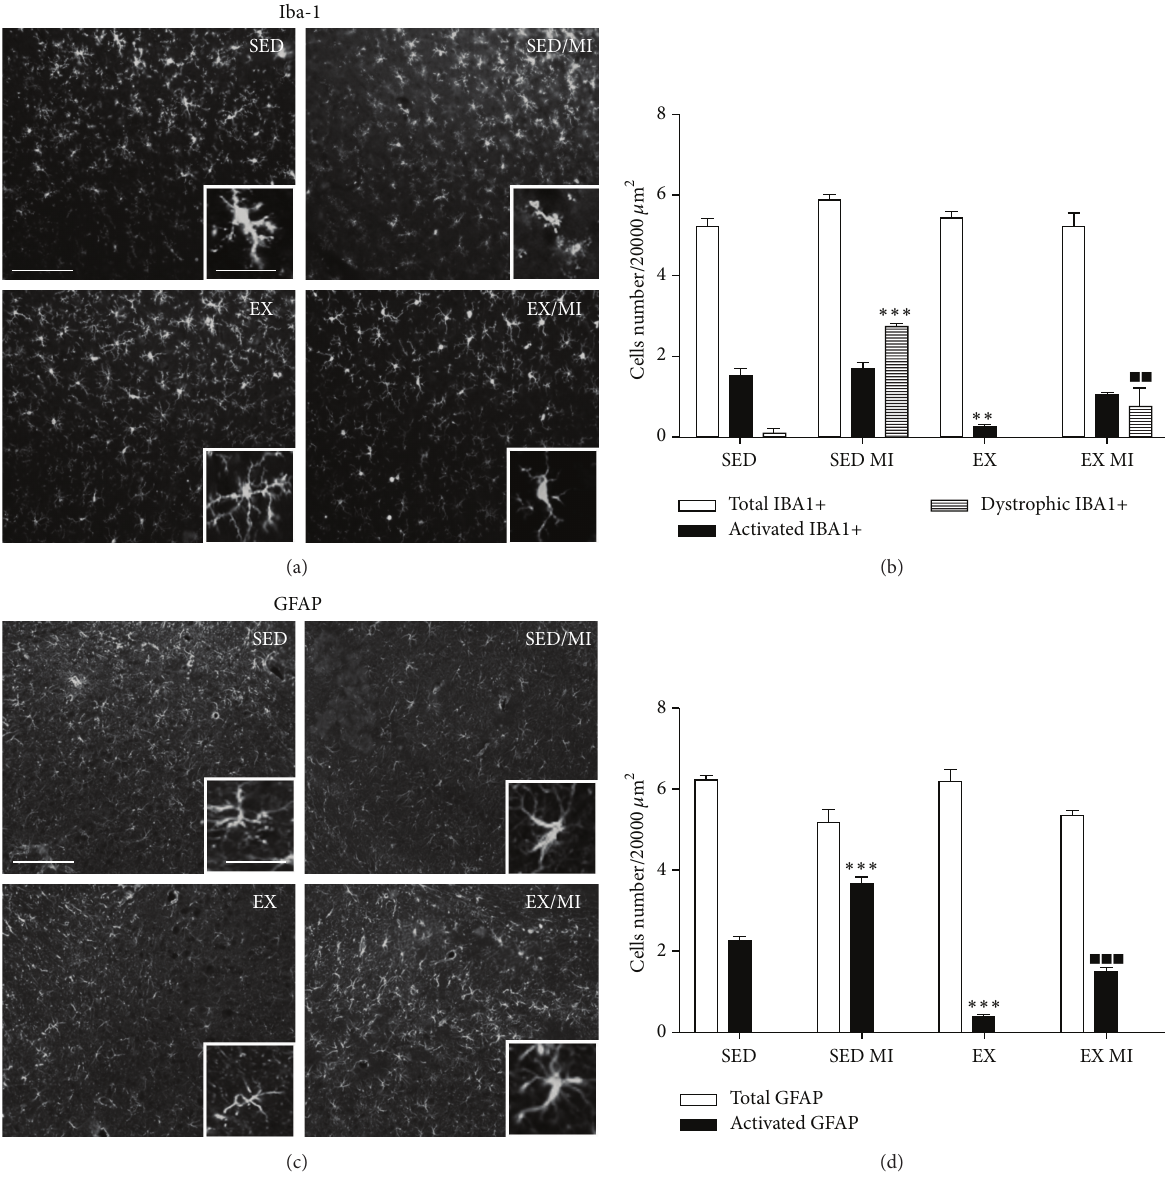
Figure 4: Effect of prolonged exercise on MI induced microglia and astrocyte morphological changes in the thalamus. 48 h MI induced significant changes in the senescent ( 2.7 ± 0.12 ) (dystrophic-like) microglia in the thalamus as compared to the sedentary group without MI ( 0.11 ± 0.11 ). Both phenotypes were significantly reduced by the prolonged exercise 0.7 ± 0.44 (a, b). 48 h MI induced increased number of reactive astrocytes ( 3.6 ± 0.19 ) as compared to the sedentary group without MI ( 2.25 ± 0.08 ). Exercise significantly reduced the number of reactive astrocytes in MI animals ( 1.5±0.08 ) (c, d). Data are presented as mean ± SEM. ANOVA followed by Tukey post hoc test was used for statistical analysis. Four animals were used for each experimental group. ∗ 𝑃 < 0.05, ∗∗ 𝑃 < 0.01 , and ∗∗∗ 𝑃 < 0.001 versus sedentary group; z 𝑃 < 0.05 , zz 𝑃 < 0.01 , and zzz 𝑃 < 0.001 versus sedentary group with MI. Scale bars 100 and 25 𝜇 m for panoramic and inset image, respectively. Scale bars 100 and 25 𝜇 m for panoramic and inset image,